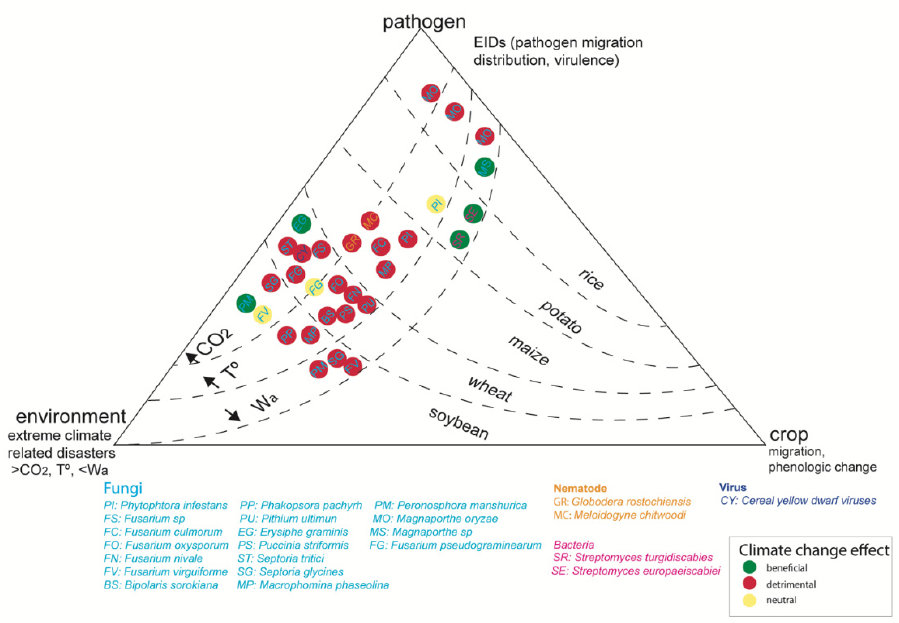
Figure 2. Effect of climate change on key crops (rice, potatoes, cereal, soybean); red: detrimental effect; yellow: neutral or unclear effect; green: desirable effect, under >CO 2 , >T ◦ , <Wa (water availability).